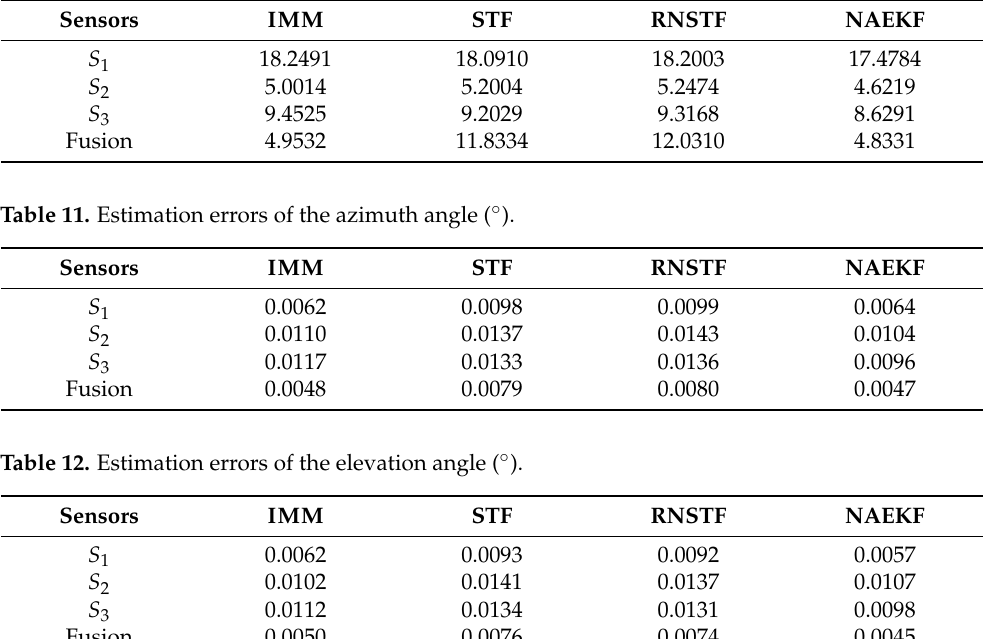
Table 10. Estimation errors of the range (m).